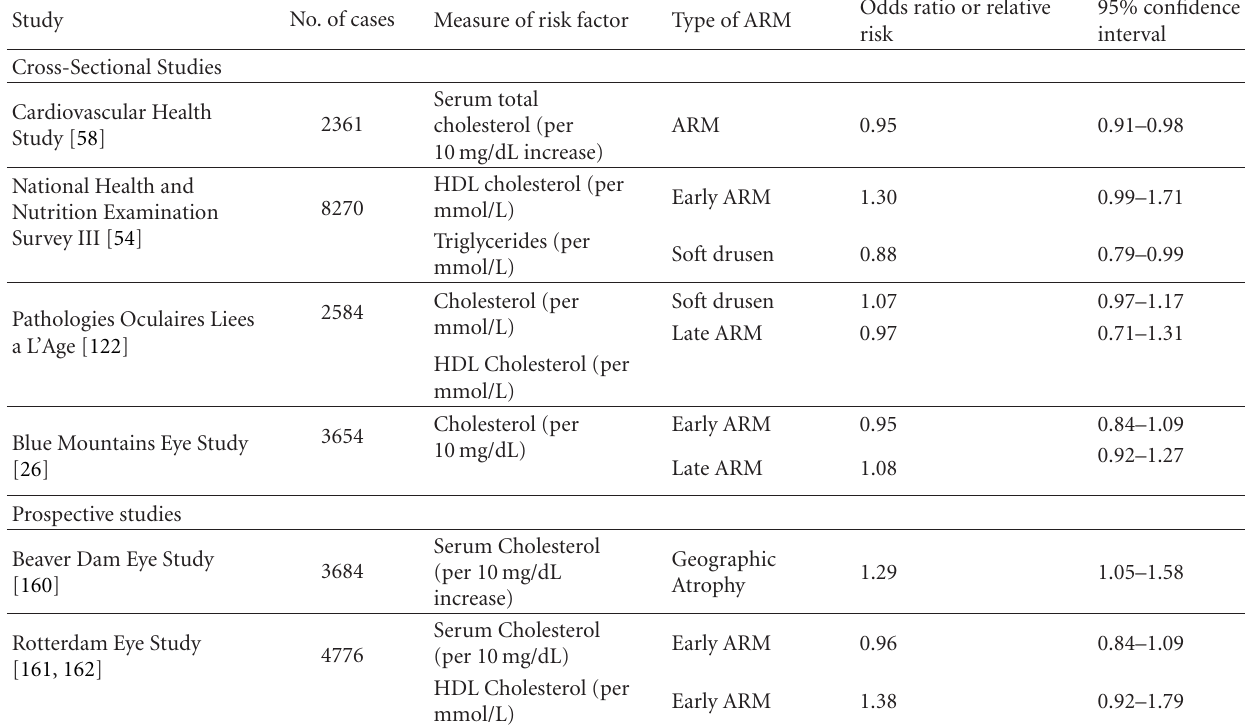
Table 5: Studies investigating the relationship between cholesterol and risk for